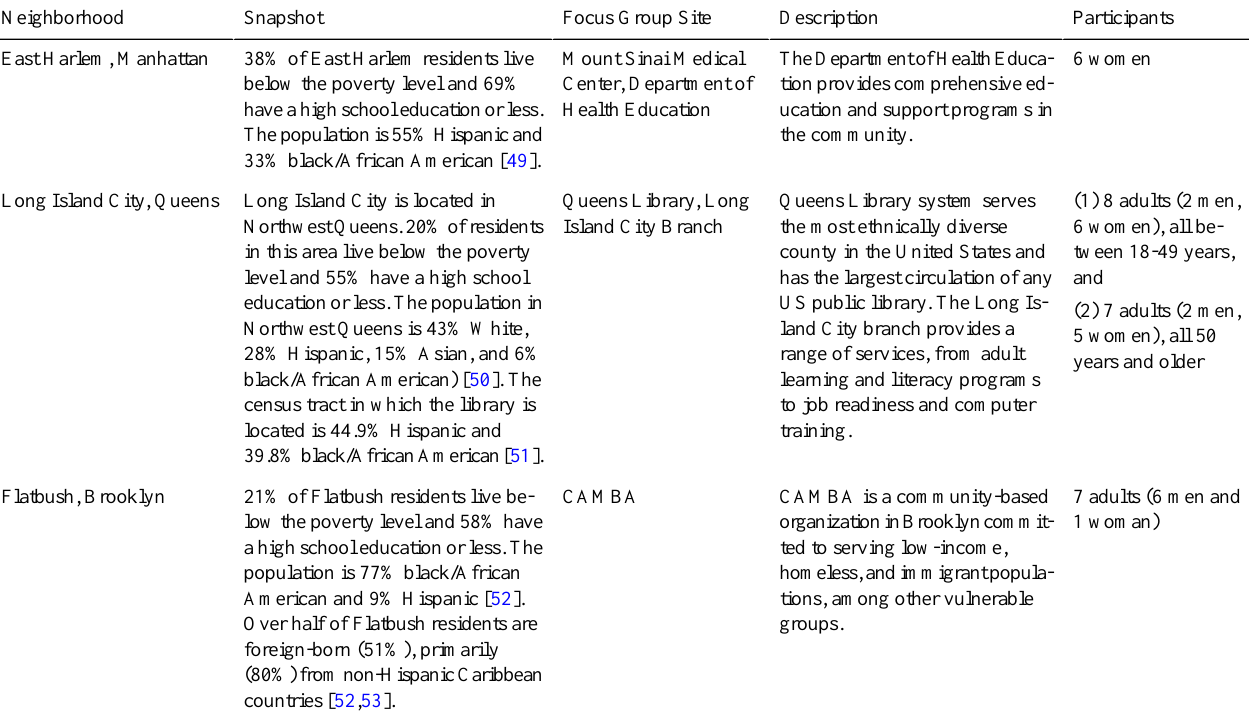
Table 1. Focus group sites and participants.